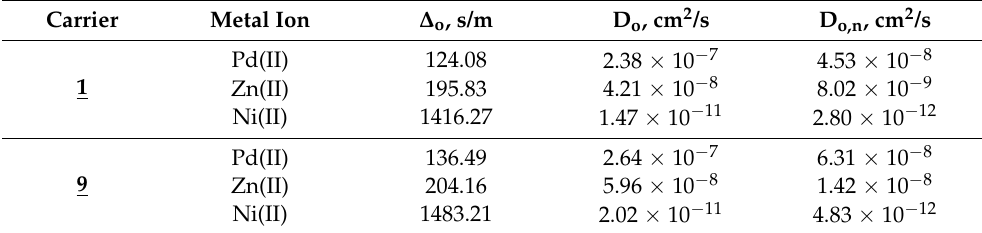
Table 9. Diffusion coefficients normalized for competitive transport of Pd(II), Zn(II) and Ni(II) ions through PIM doped with 1-pentyl-triazole ( 1 ) and 1-hexadecyl-triazole ( 9 ). Carrier